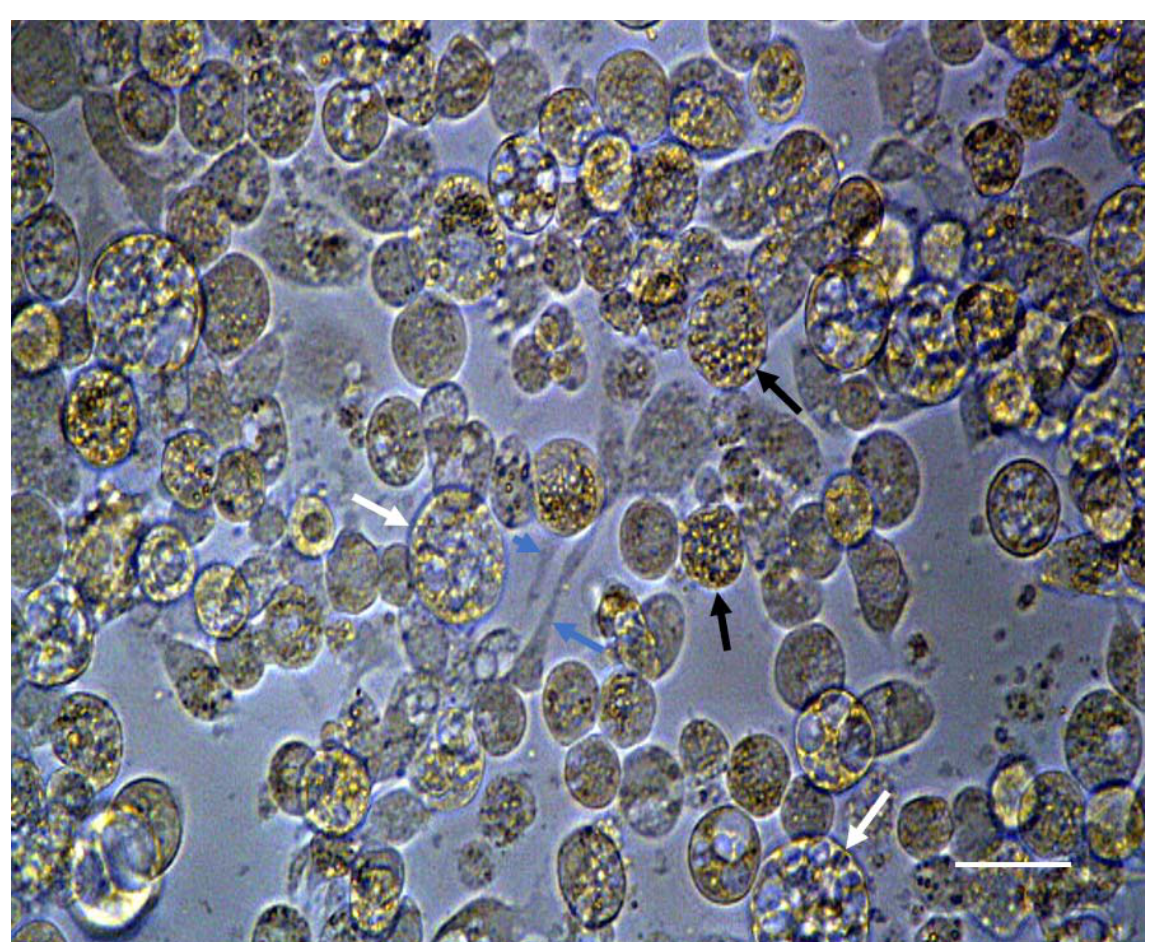
Figure 3. Light microscopy of passage 14 BmVIII-SCC cells cultured in a Primaria flask (View: 400 × ). Fibroblast-like cells (blue arrows), large vacuolated cells (white arrows), and small granular cells (black arrows). Scale bar: 2.5 µ